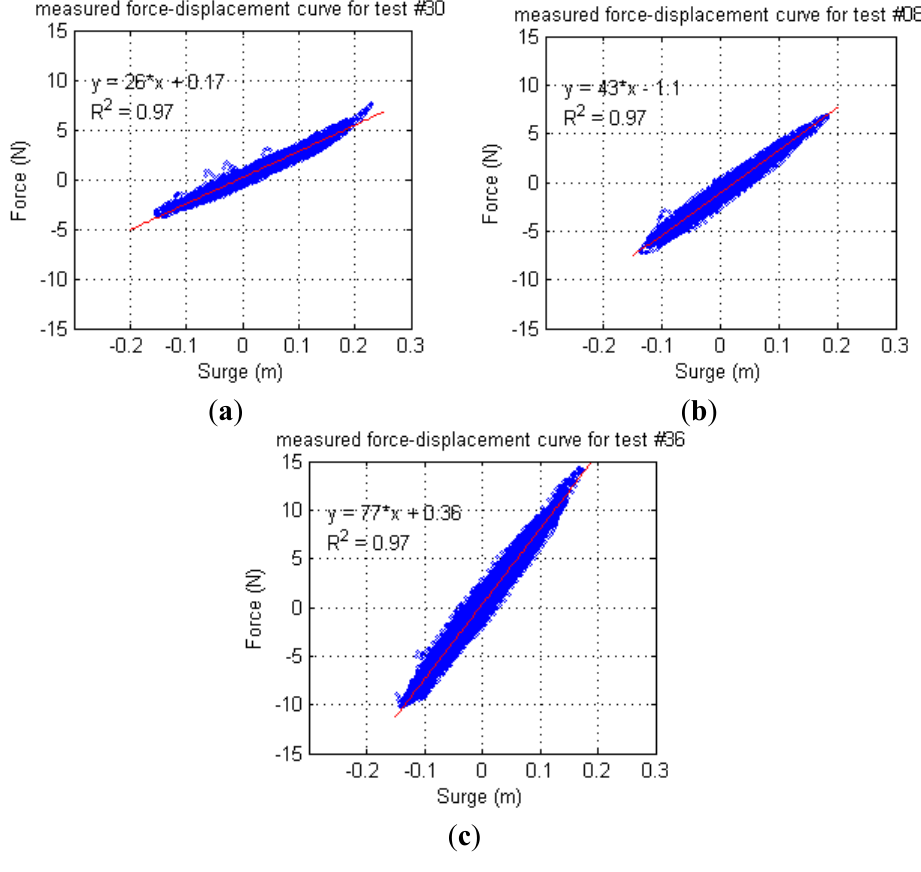
, S ), with low R r 100 p 0 c